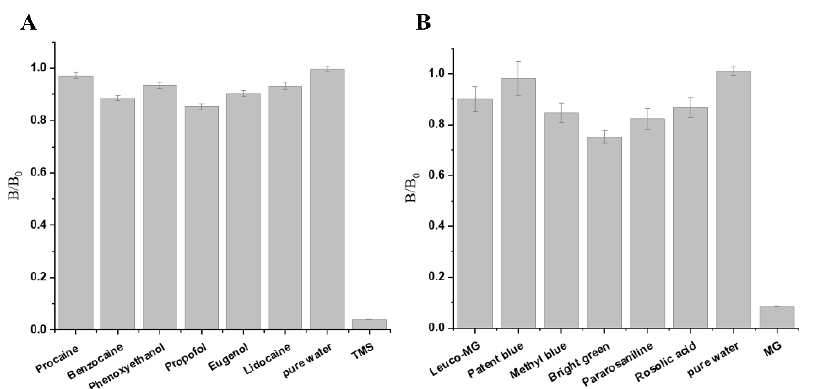
Figure 3. Specificity evaluation of TS-DTL for the detection of TMS and MG. ( A ) Specificity test of TMS and 6 other anaesthetics; ( B ) Specificity test of MG and 6 other